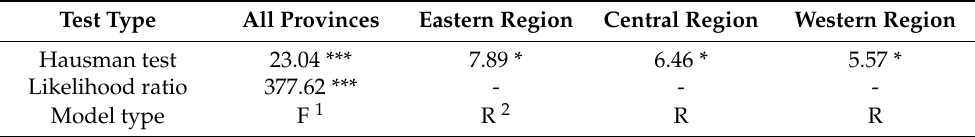
Table 2. Selection results of panel data model (1996–2005).